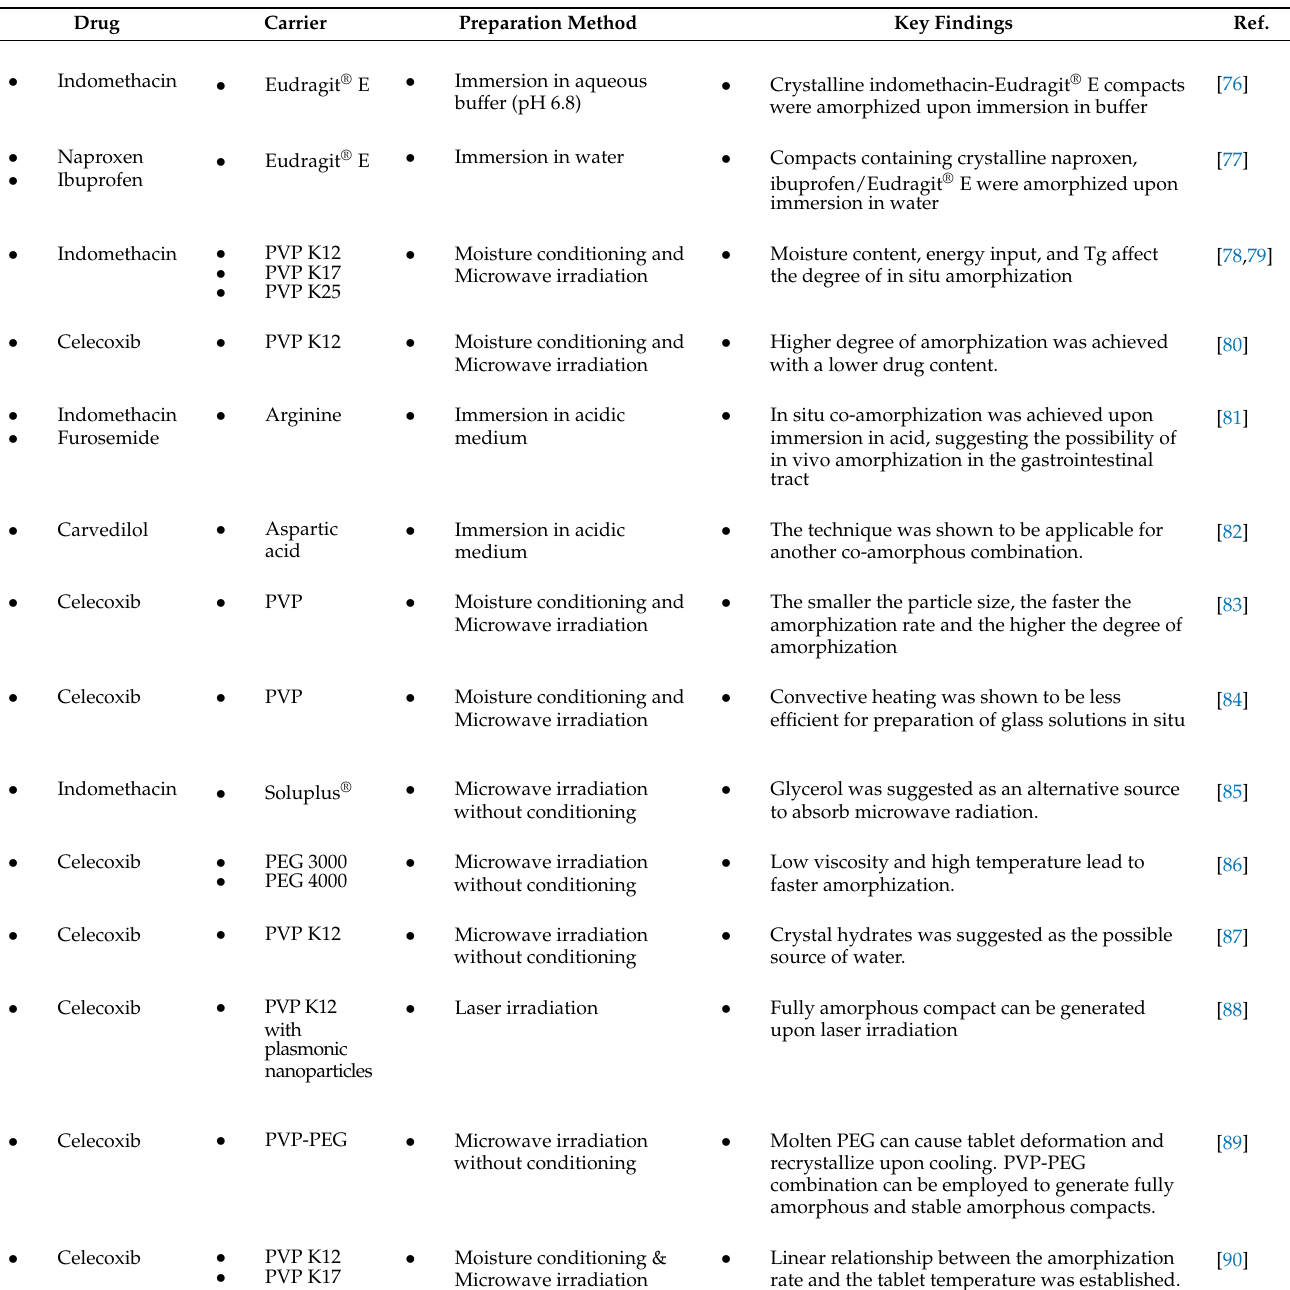
Table 7. Recent examples of in situ amorphization employing solid dosage